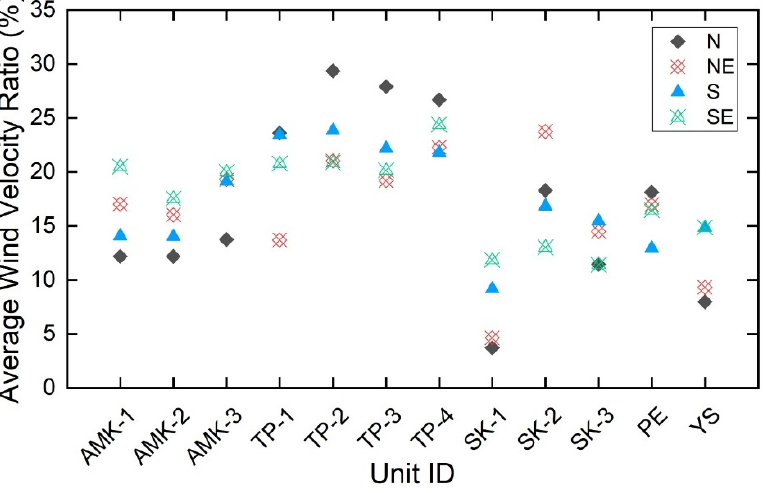
Figure 14. Average wind velocity ratios in all the target units.